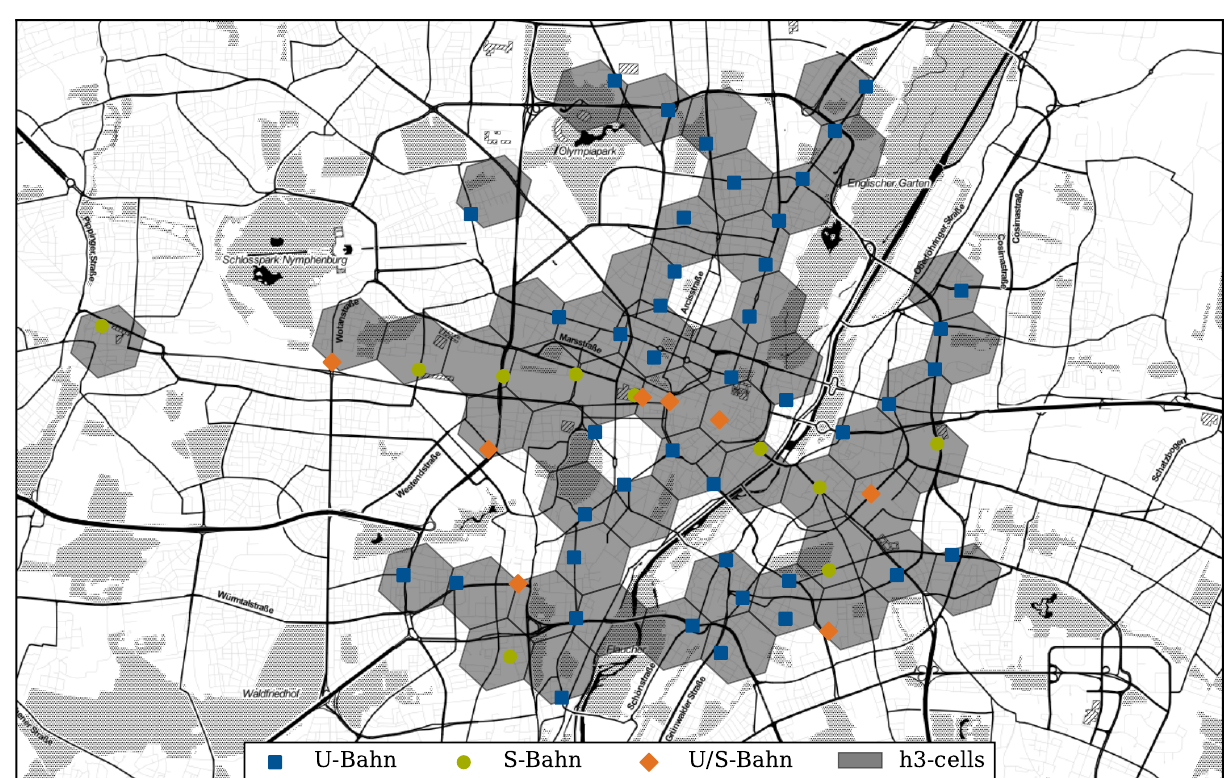
Figure 7. Considered Hexagons (in grey shading) with Suburban Railway (green dots), Underground (blue squares) stations, or a Combination of both (orange